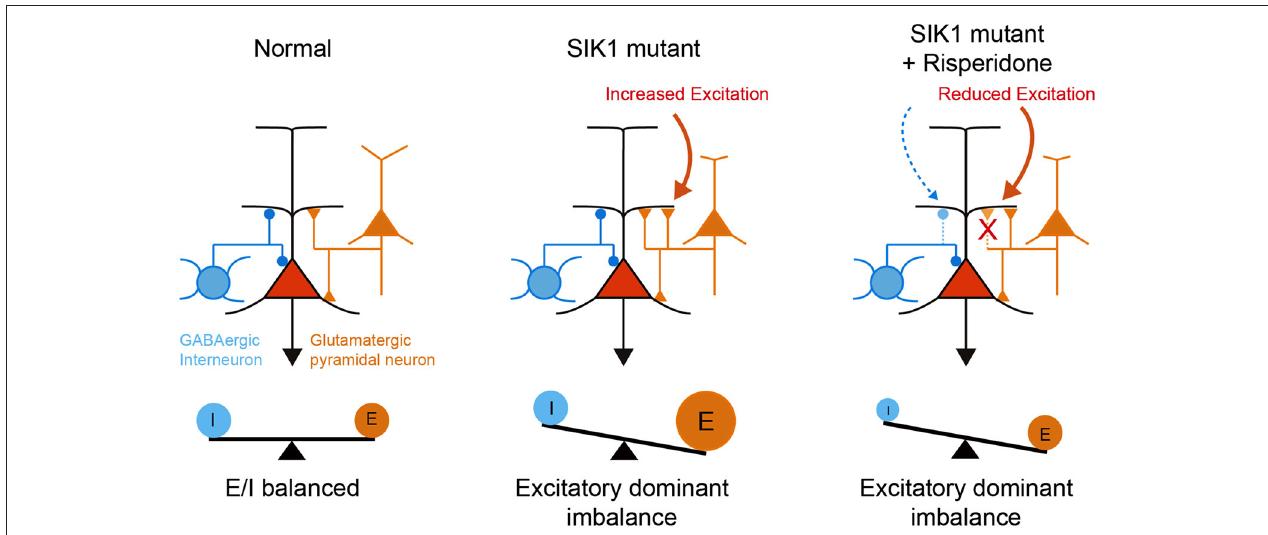
FIGURE 7 | A schematic illustration of neuronal abnormality in SIK1-MT mice. In SIK1-MT mice, excitatory synaptic input onto pyramidal neurons in layer 5 of mPFC is increased, resulting in the disruption of E/I balance (middle). Risperidone restores the increased excitatory synaptic input. Risperidone also decreases the inhibitory input onto the pyramidal neurons. As a result, disrupted E/I balance is maintained in the risperidone-treated SIK1-MT mice (right).